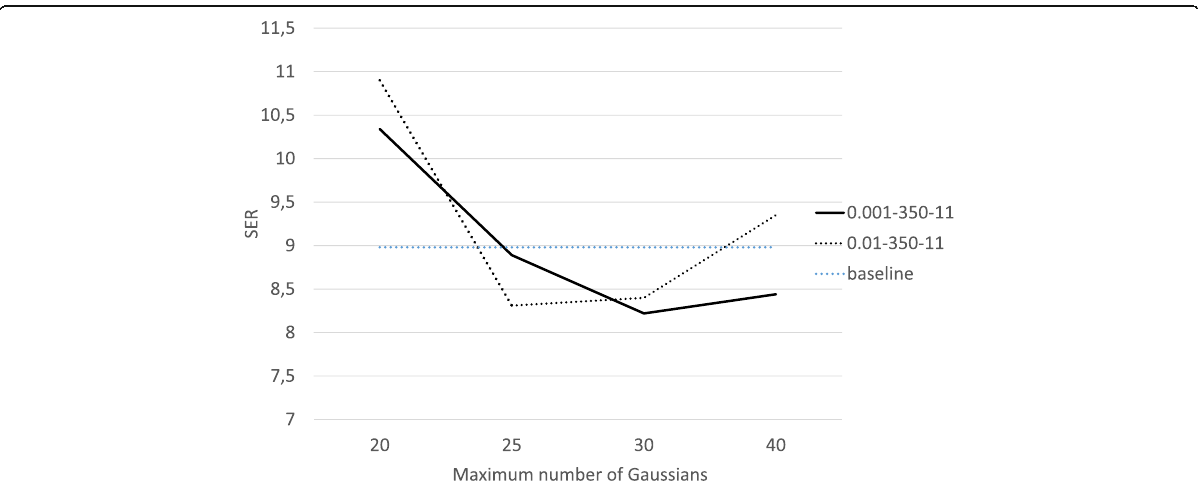
Fig. 18 SER for the DEVELSET using a single mfcc stream across the maximum number of Gaussians and different sets of